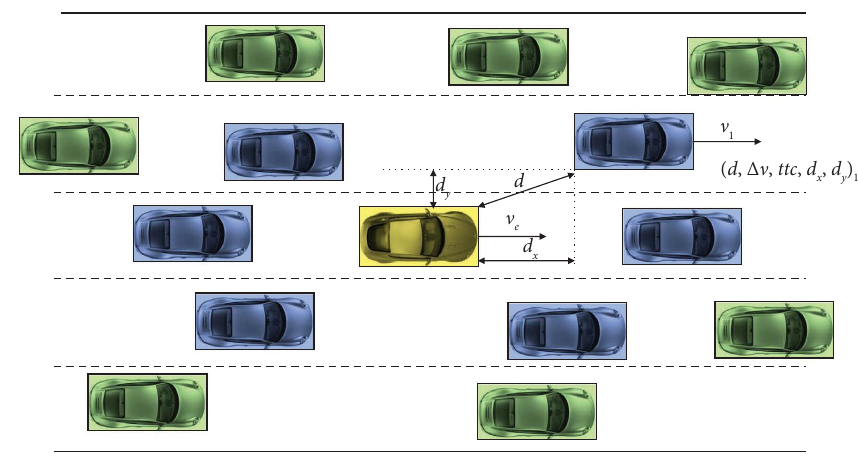
Figure 3: State representation of the surrounding